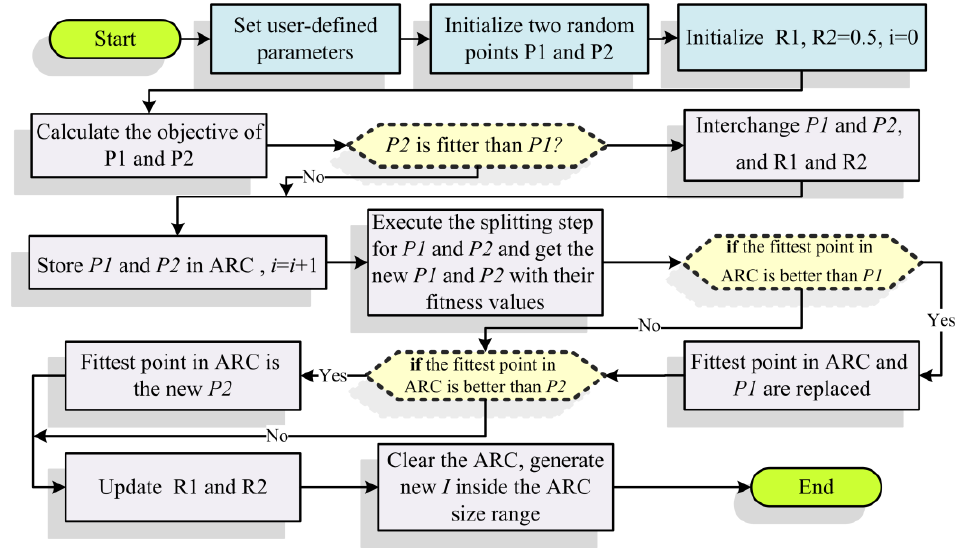
Figure 1. The structure of YYPO